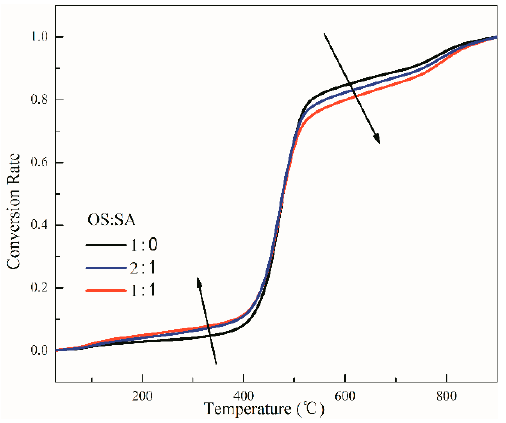
Figure 2. Conversion curves of different mass ratios of OS and SA.